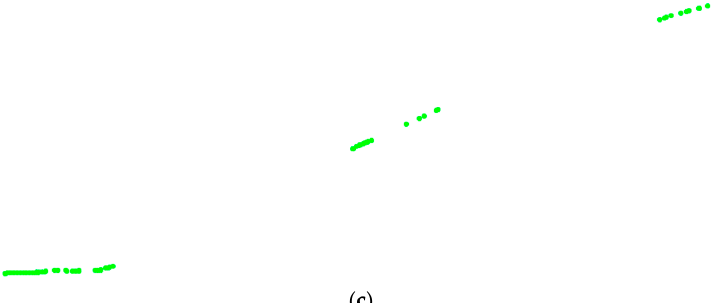
Figure 11. Filtering results of the steep area with different N1 : ( a ) filtering result with N1 covers about 0.5 m of the neighborhood; ( b ) filtering result with N1 covers about 4.0 m of the neighborhood; ( c ) filtering result with N1 covers about 8.0 m of the neighborhood.